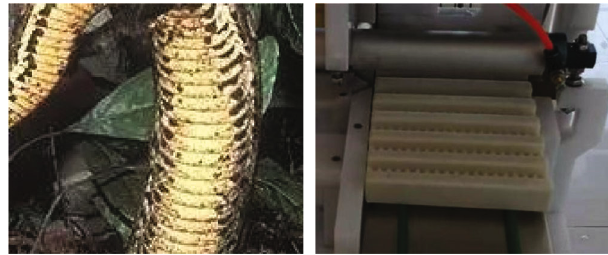
Figure 13: The biological prototype of the walking plate structure.